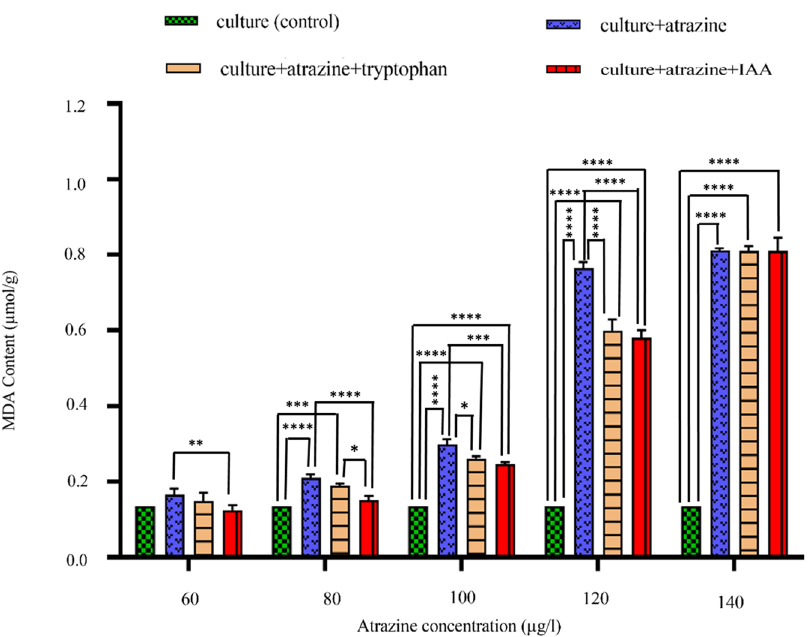
Figure 5. Intergroup and intragroup comparison of mean levels of MDA content on the 24th day in C. stagnale , using two-way ANOVA and Tukey’s multiple comparison test respectively (*p < 0.05; **p < 0.01; ***p < 0.001; ****p < 0.0001). The ANOVA results for MDA showed that all four treatments had a different effect on the MDA content. Furthermore, Tukey’s multiple comparison test demonstrated that at low concentrations of atrazine (60 and 80 μg/ml), all the three treated sets show similar MDA content in comparison to the control, and therefore the difference in the values was statistically non-significant. At higher concentrations of atrazine (100, 120, and 140 μg/ml), the MDA content in all the three treated sets increased drastically, as a result of which the difference was statistically significant with control but the values were similar to each other and therefore the difference was statistically non-significant when the sets containing atrazine were analogized to each